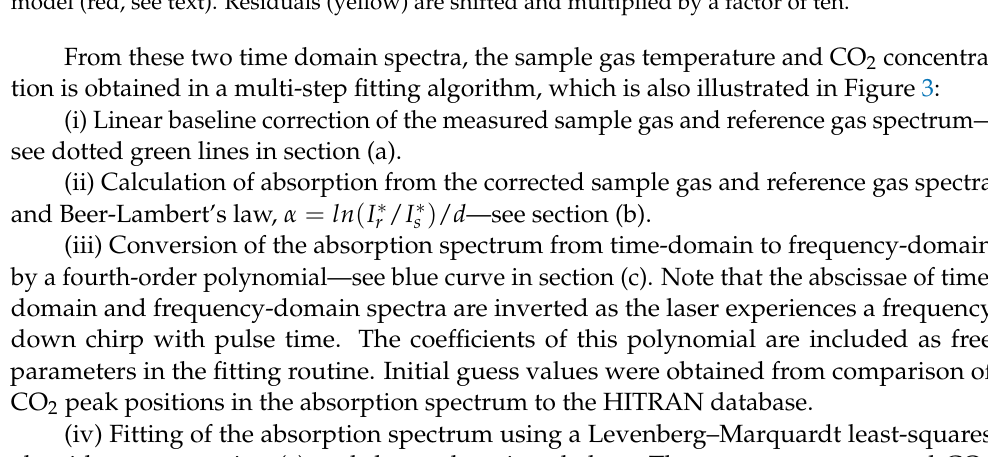
Figure 3. Exemplary data and illustration of the algorithm for temperature measurements: ( a ) Time domain intensity spectra recorded on 5% CO 2 gas (blue) and a reference gas (N 2 gas, black), obtained at T ∼ 293 K, ( b ) Time-domain absorption spectrum derived from the spectra in section ( a ), and ( c ) Frequency-domain absorption spectrum (blue) and best-fit to the HITRAN-based absorption model (red, see text). Residuals (yellow) are shifted and multiplied by a factor of